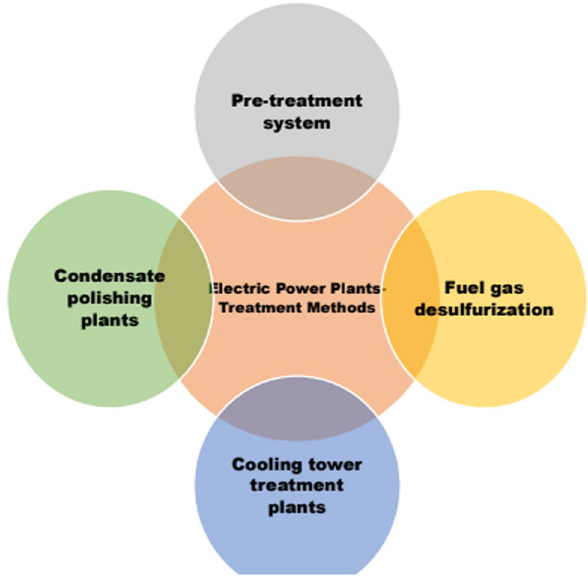
Fig. 2 Treatment methods of electric power plants